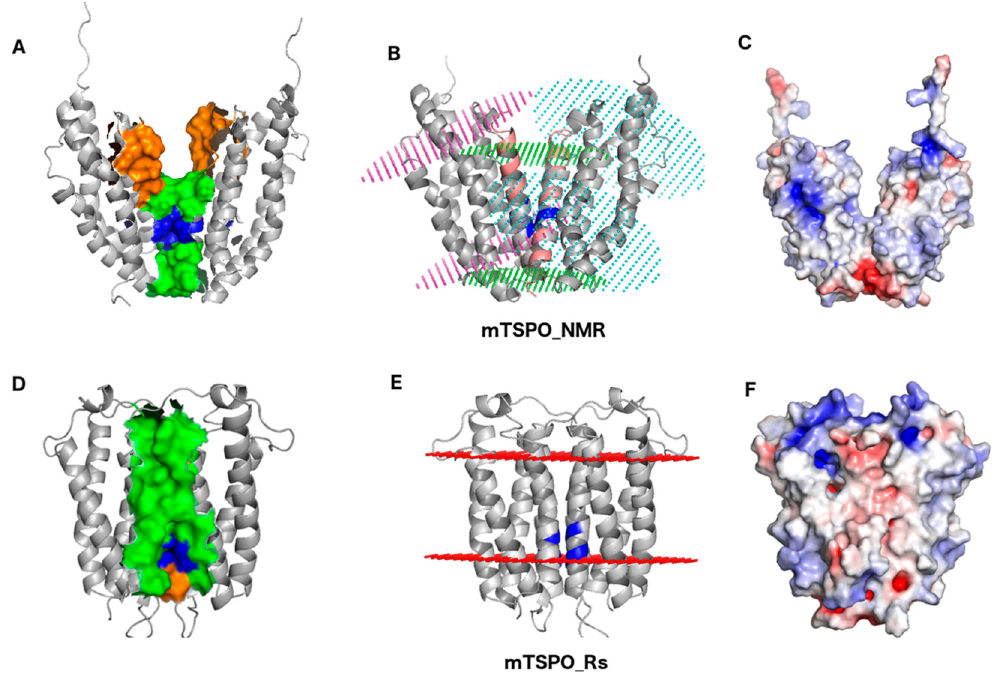
Figure 2. The mTSPO_NMR ( A – C ) and mTSPO_Rs dimers ( D – F ). ( A ) The G83XXXG87 motif (blue surface) of mTSPO_NMR is located at the dimer interface, consistently with the experimental findings [20] (Table 1). Other residues participating to the dimer interface in the model and according to experiment [20] are represented by green and orange surfaces, respectively. ( B ) Embedding of mTSPO_NMR in a bilayer membrane according to the PPM server [35]. The membrane boundaries for the individual monomers are shown by pink and cyan spheres. Glycophorin A (PDBiD: 5EH4, shown as pink ribbons) has been used as template to build the dimer, following the procedure of [20]. The membrane boundaries of this protein derived from the Orientation of Proteins in Membranes (OPM) database [35] are shown as green spheres. The membrane boundaries of mTSPO_NMR are not parallel to those of the template guiding the dimerization. ( C ) mTSPO_NMR electrostatic surface potential. The surface potentials are calculated using APBS [37]. Red and blue surfaces represent negative and positive electrostatic potentials ( − 5 kT/e, +5 kT/e), respectively. The exposed positively charged (blue) surface in are generated by R27, R46, R156, and R161. ( D ) The blue surface shows the G83XXXG87 motif of mTSPO_Rs. The green surface shows the other residues participating to the dimer interface in each monomer. The orange surface shows the residues participating to the dimer interface according to the experimental assignments data [20] not already included in the previous selections. ( E ) Embedding of mTSPO_Rs in a bilayer membrane according to the PPM server calculations. The membrane boundaries are shown in red. ( F ) mTSPO_Rs electrostatic surface potential. These residues that are exposed towards the lipid membrane in C , have now the sidechains oriented towards the